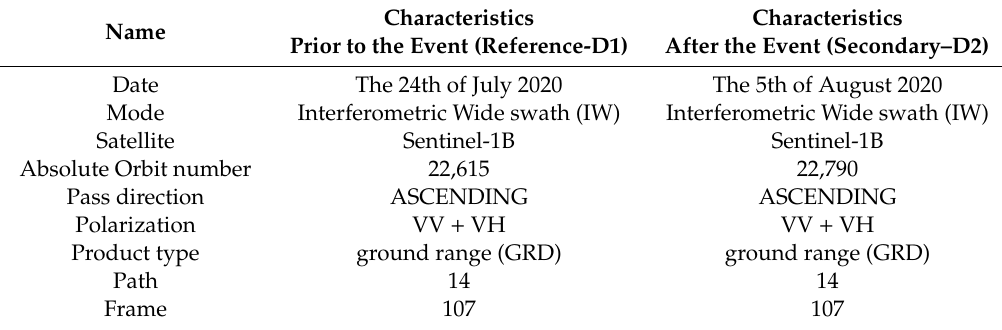
Table 1. Sentinel-1 data used for the change detection analysis.